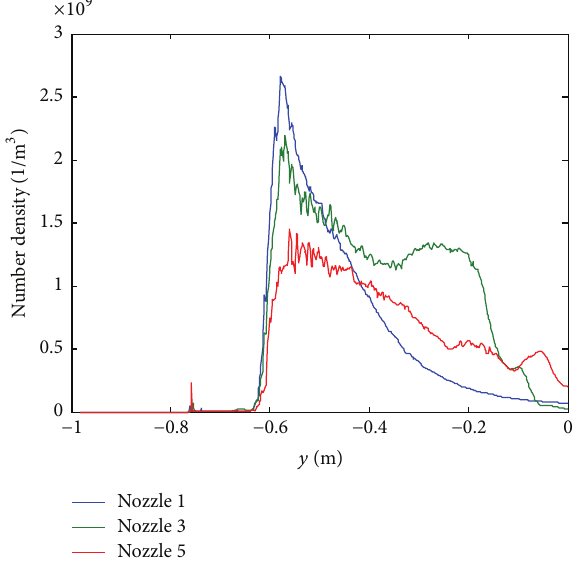
Figure 12: Plot of the number density of bin fraction